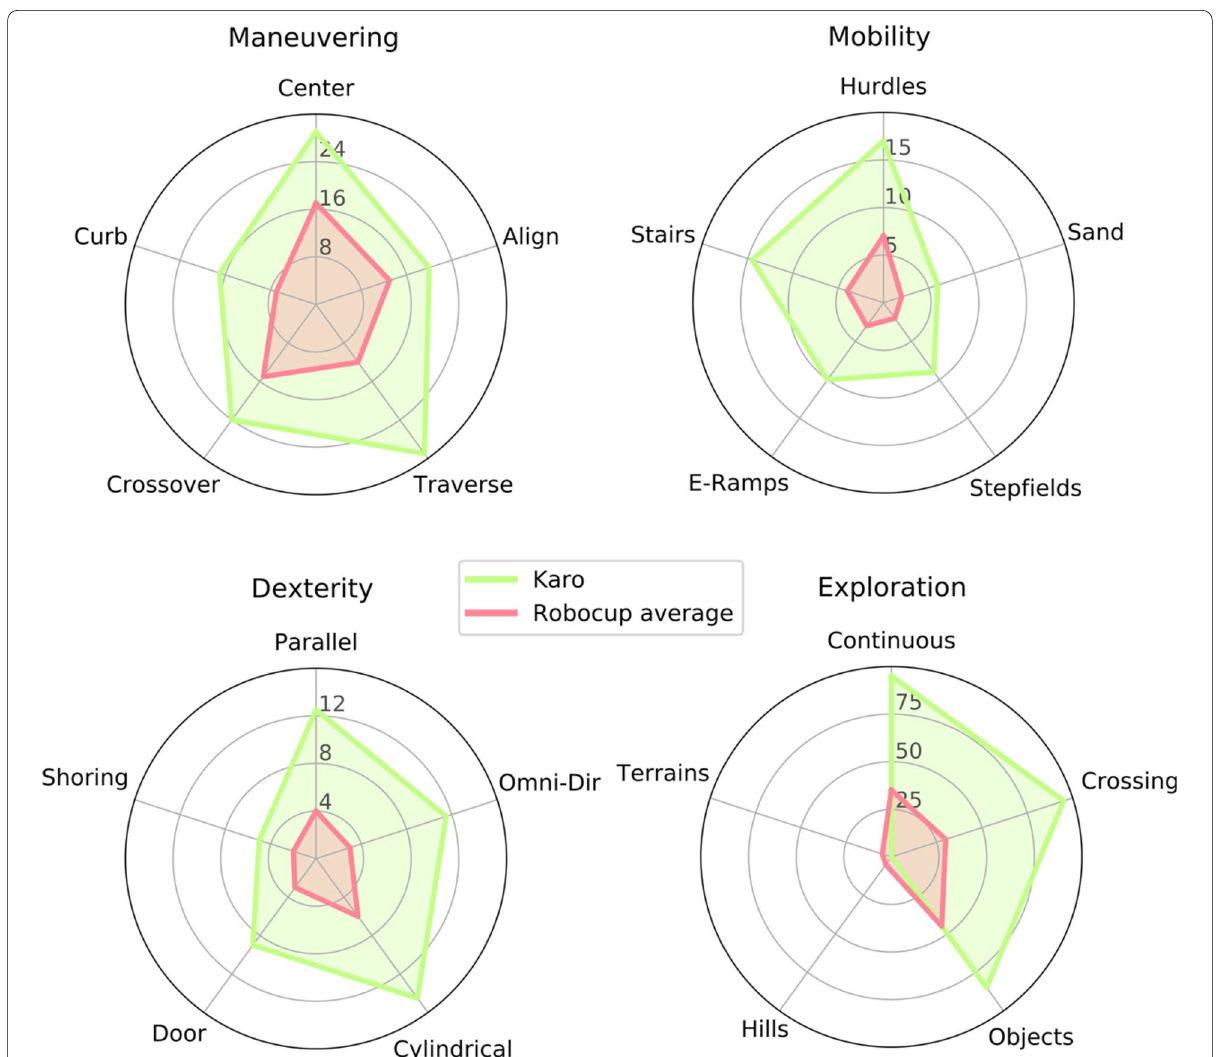
Fig. 25 Drawing a comparison between Karo’s performance and the RRL’s mean performance in all four test suits (based on the results from RRL